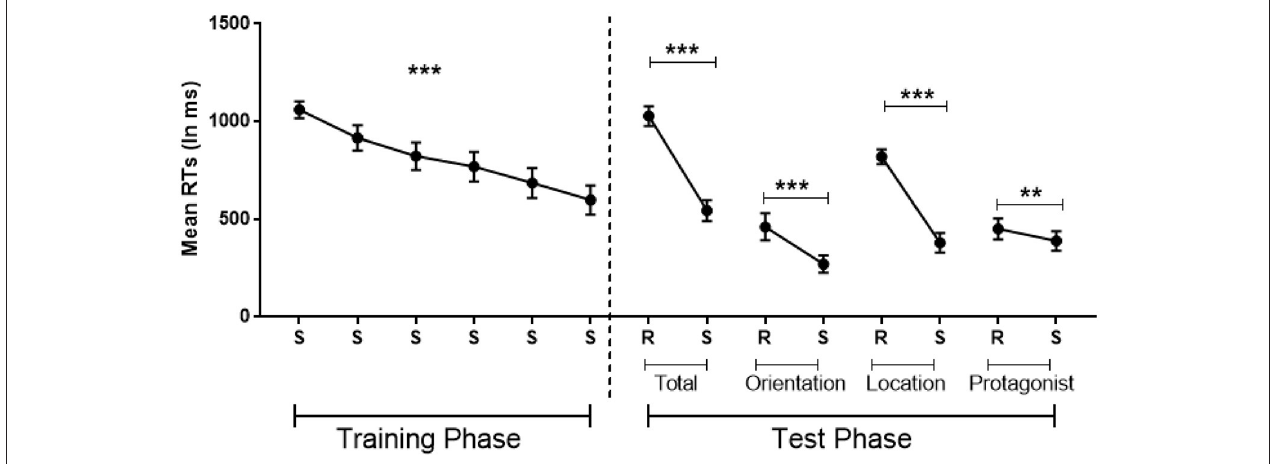
FIGURE 3 | Implicit learning of the belief-related sequence in which the sequence is standard (S) or random (R), with randomization involving belief orientation (Orientation: true or false), the flower’s location (Location: 1–4) or the protagonists identity (Protagonist: Papa smurf or Smurfette) or these three dimensions together (Total). Error bars = Standard errors of the mean. Standard blocks adjacent Random blocks of the same dimension were collapsed in the analysis. ** p < 0.01; *** p <